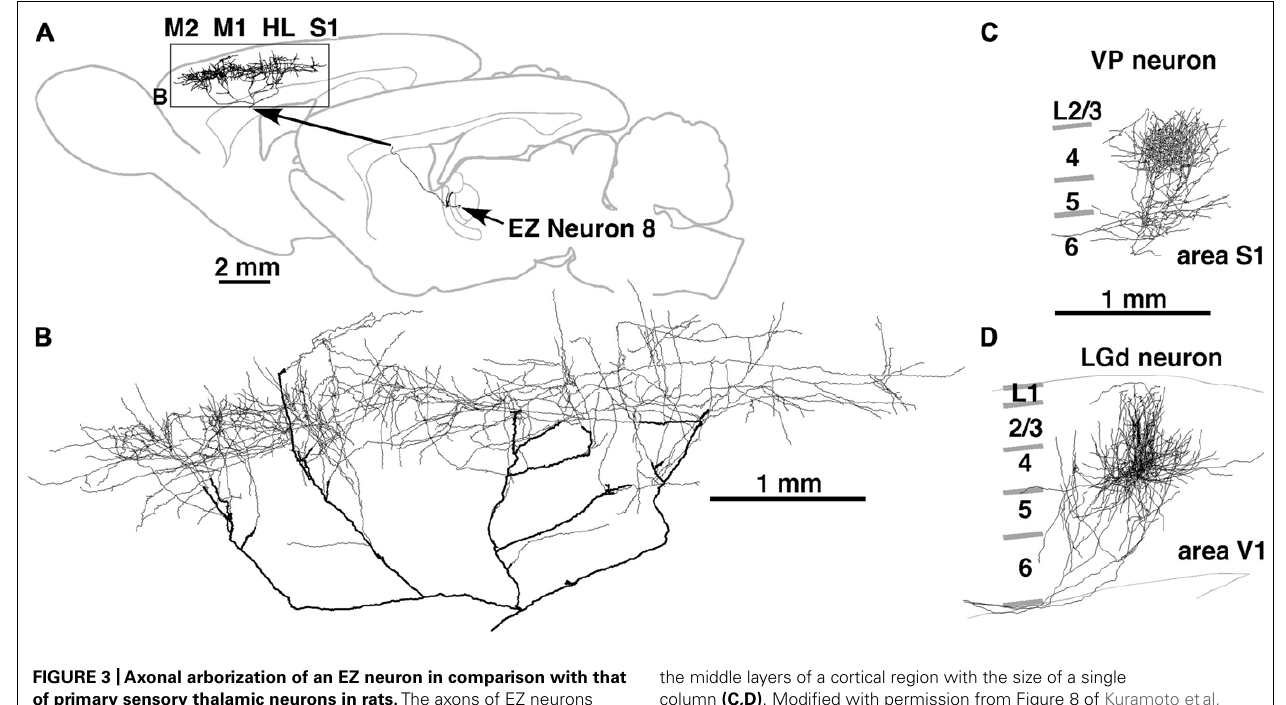
the middle layers of a cortical region with the size of a single column (C,D) . Modified with permission from Figure 8 of Kuramoto etal. (2009) (A,B) and Figure 3 of Furuta etal. (2011) (C) .The axonal arborization of a single LGd neuron in areaV1 (D) was labeled and illustrated with the same method as that in Kuramoto etal. (2009) by Nakamura and